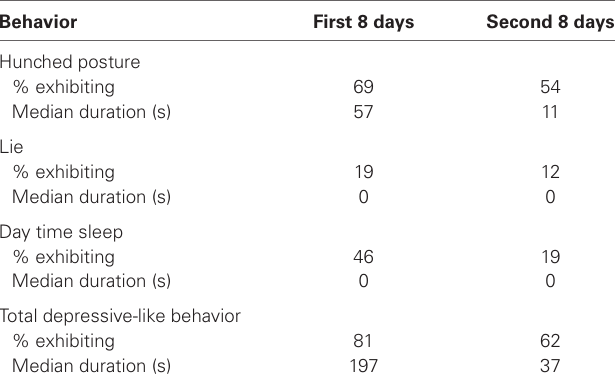
Table 2 | Per cent males exhibiting, and median duration of, depressive-like behaviors in Study 2 .